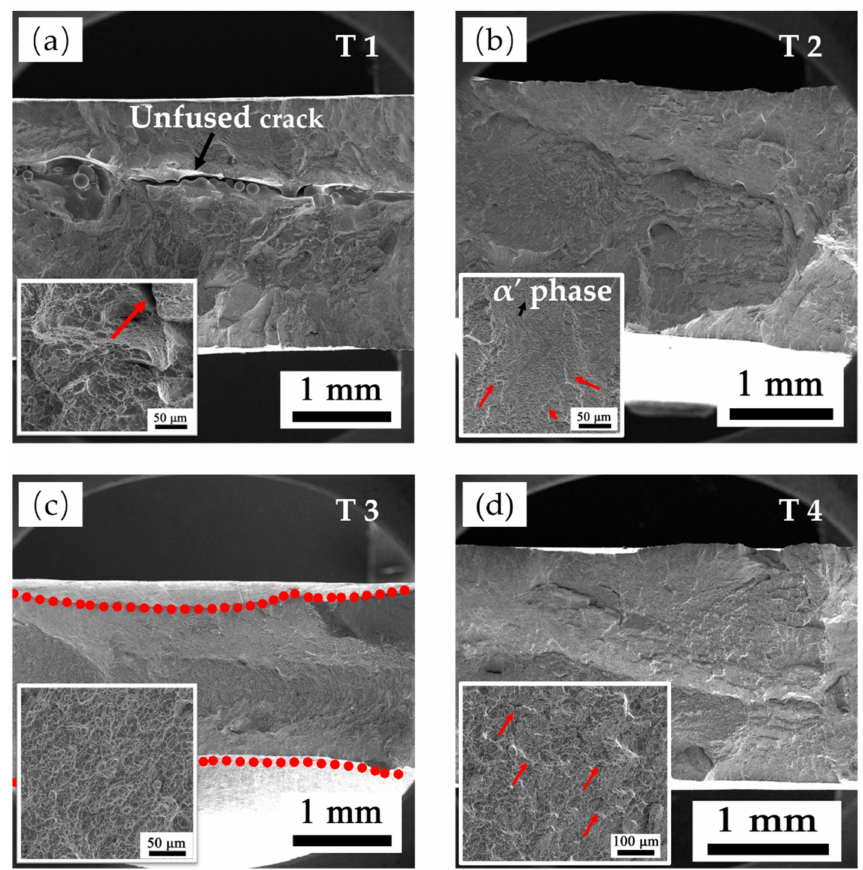
Figure 16. The tensile fractographies of LMD Ti6Al4V samples: ( a ) T1, ( b ) T2, ( c ) T3, and ( d )